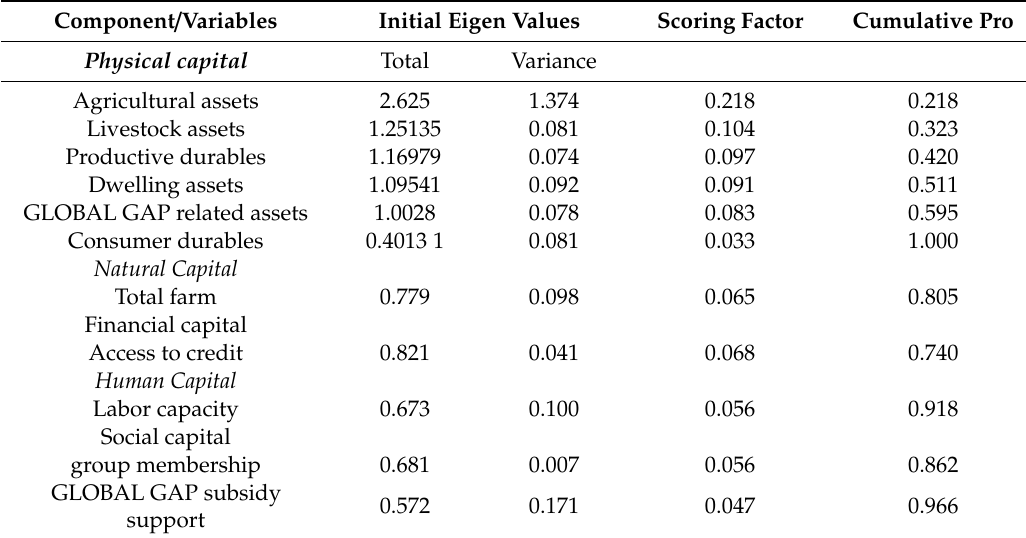
Table 1. Principle Component Analysis